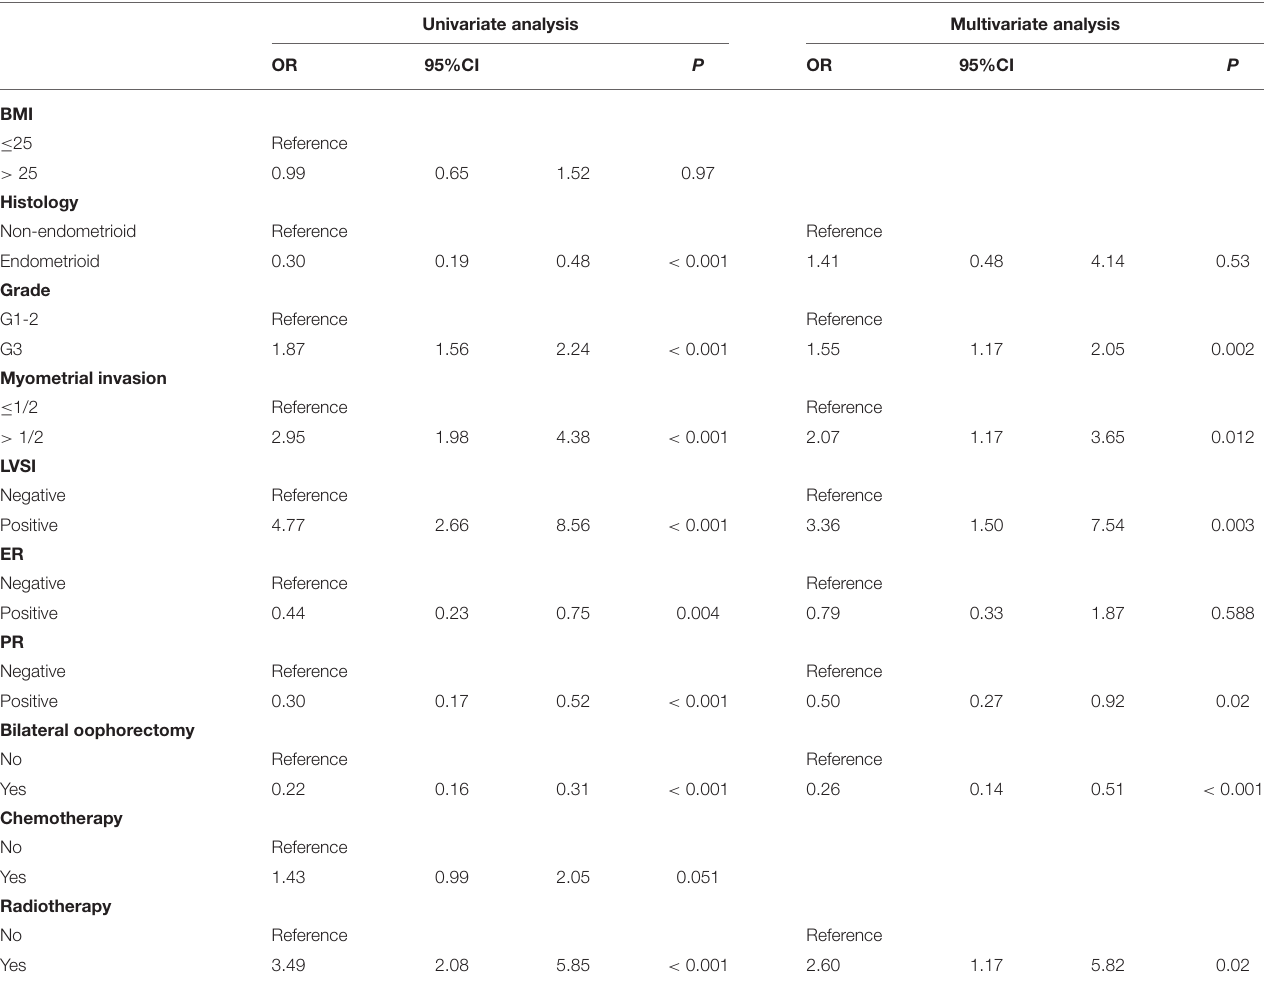
TABLE 4 | Logistics regression model analysis for early recurrence